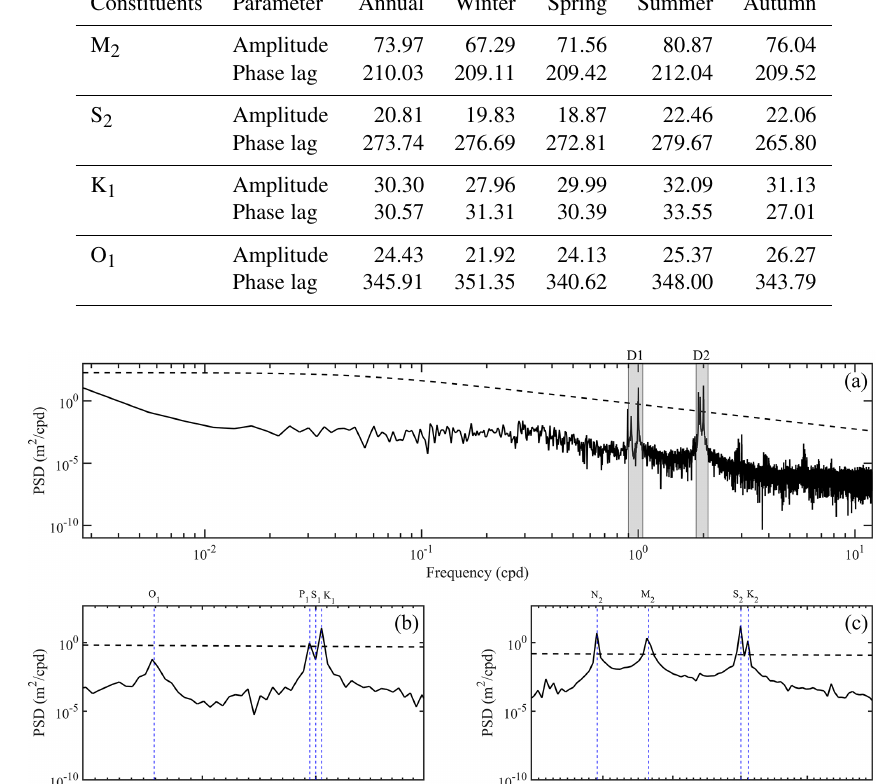
Table 1. Averaged amplitudes (cm) and phase lag ( ◦ ) of the principal tidal constituents obtained using EHA at E2. Constituents